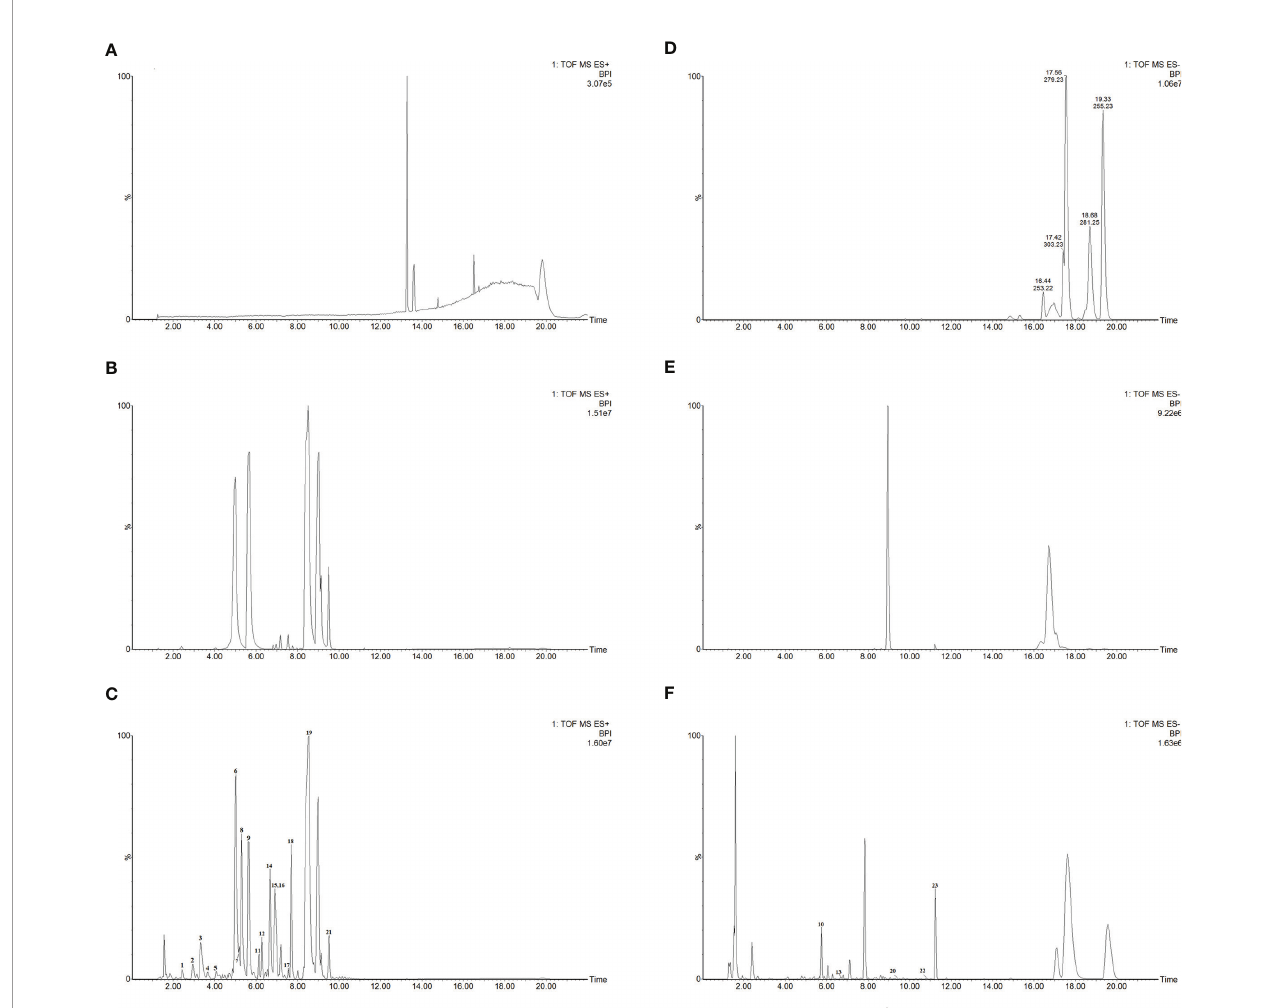
FIGURE 1 | UPLC-Q-TOF-MS analysis of CKI. Chromatographic fi ngerprints of control (A) , standard components (B) and CKI (C) in the positive ion mode. Chromatographic fi ngerprints of control (D) , standard components (E) and CKI (F) in the negative ion